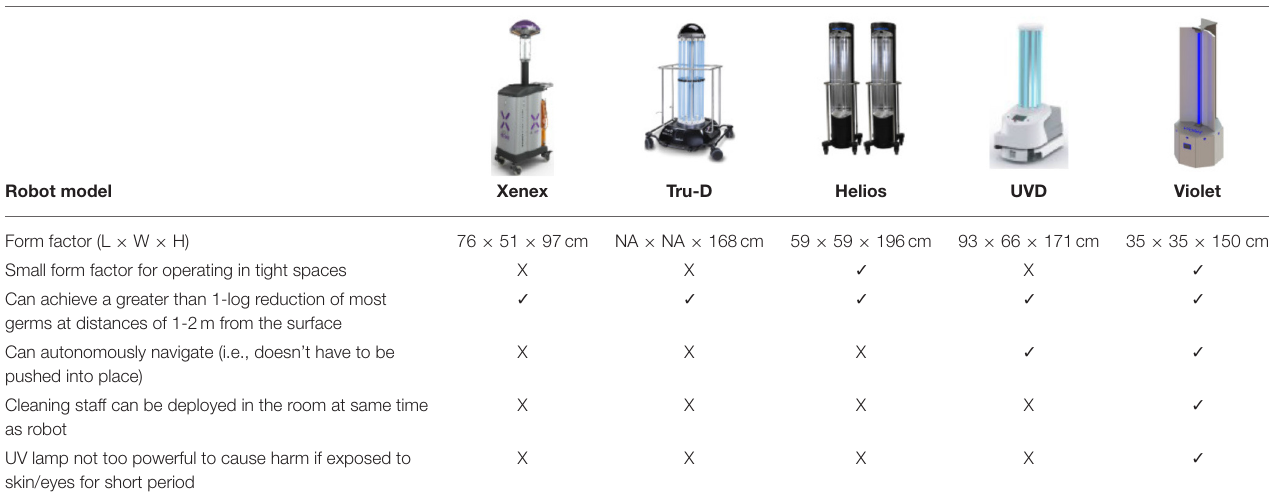
TABLE 1 | Benchmarking Violet and several existing UV robots against stated design